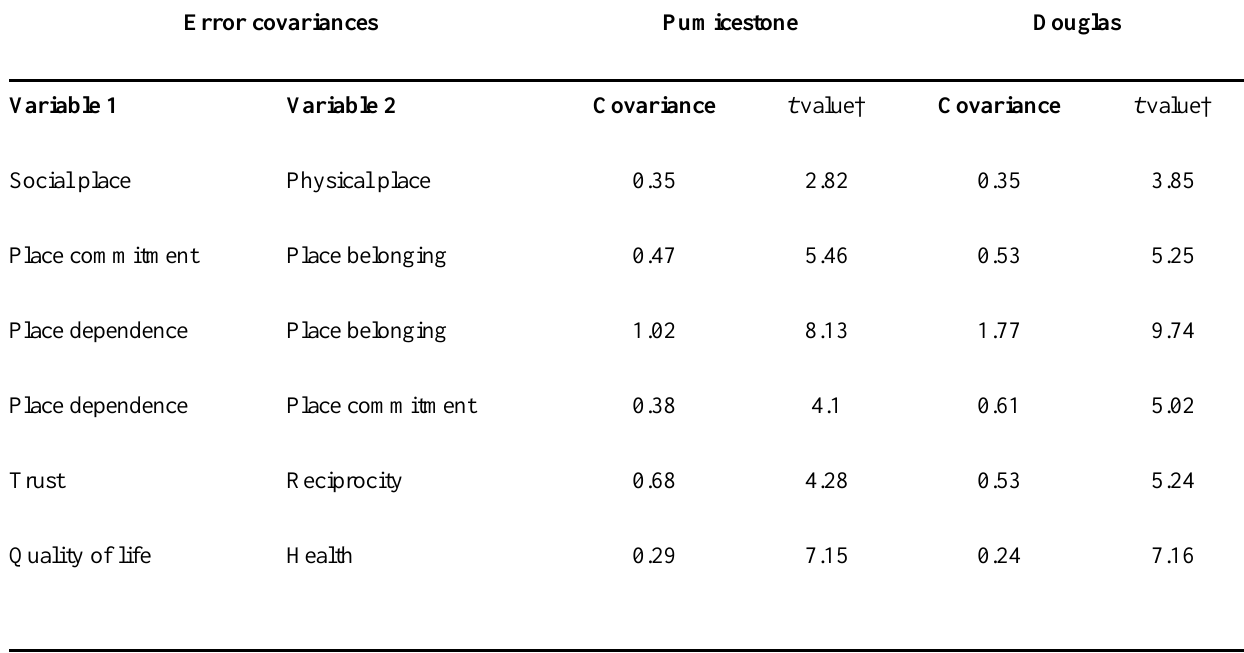
Table 6. Error covariances between related variables for the full path model in each